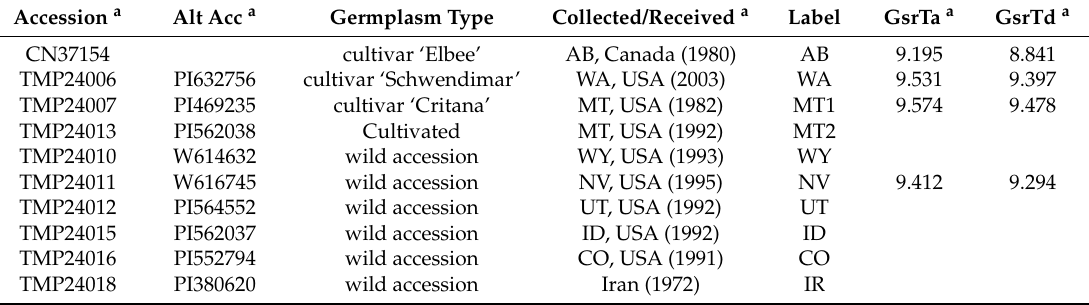
Table 1. List of the 10 northern wheatgrass ( E. lanceolatus ssp. lanceolatus ) accessions studied and their information and genome size